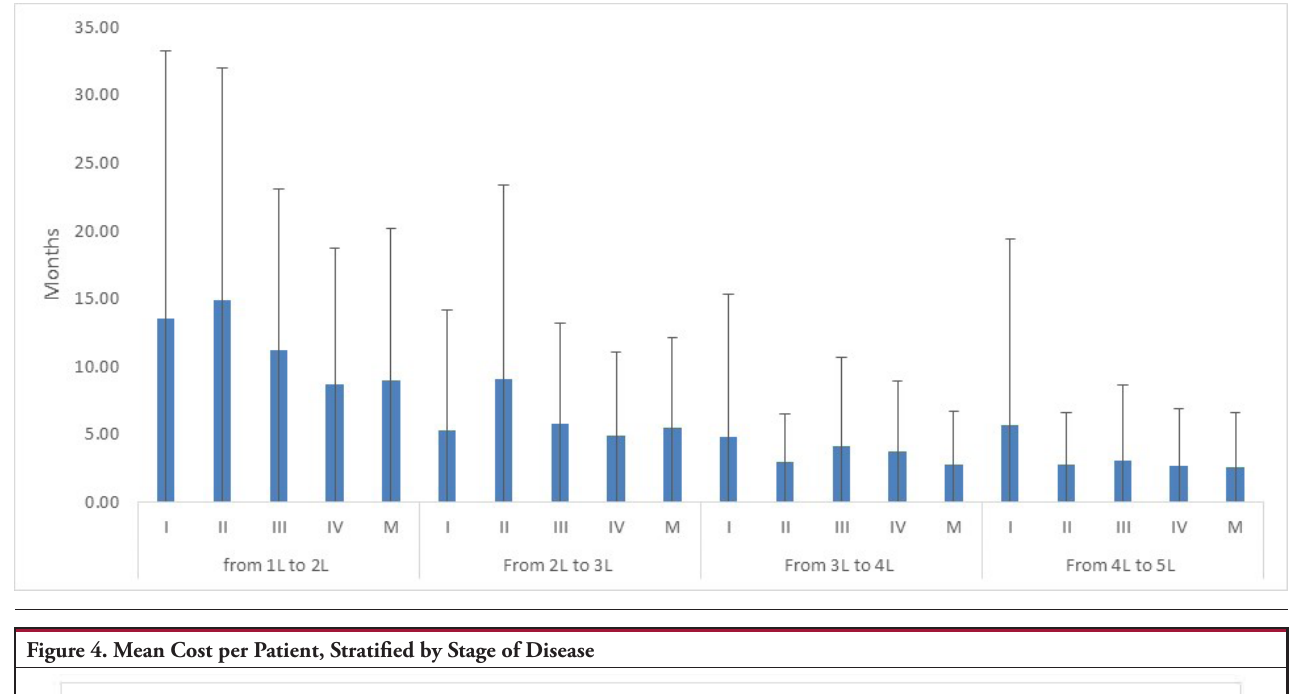
Figure 3. Time Between Lines of Treatment Stratified by Stage of Disease